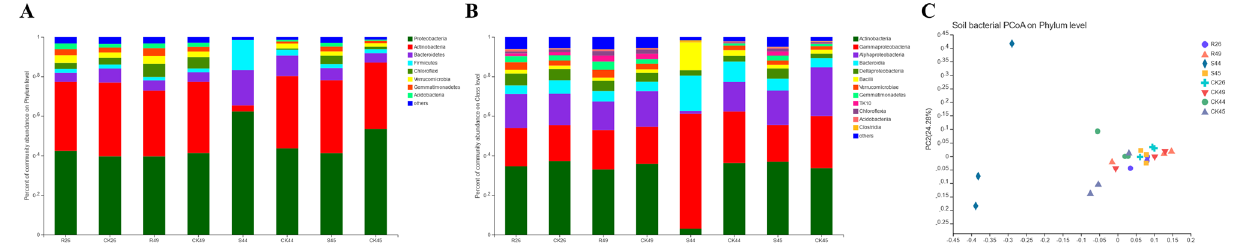
Figure 2. Taxonomic composition of bacterial communities in soil at different levels. ( A ) Taxonomic composition of bacterial communities at the phylum level, ( B ) Taxonomic composition of bacterial communities at the class level, ( C ) Principal coordinate analysis (PCoA) based on Bray–Curtis metrics for bacterial communities in soil. ‘Others’ represents the phyla and classes with relative abundances less than 1% of the total sequences. R, resistant variety inoculated with T. controversa ; S, susceptible variety inoculated with T. controversa ; CK, wheat not inoculated with T. controversa ; 26, wheat hybrid variety Mianyang 26/Yumai 47; 49,